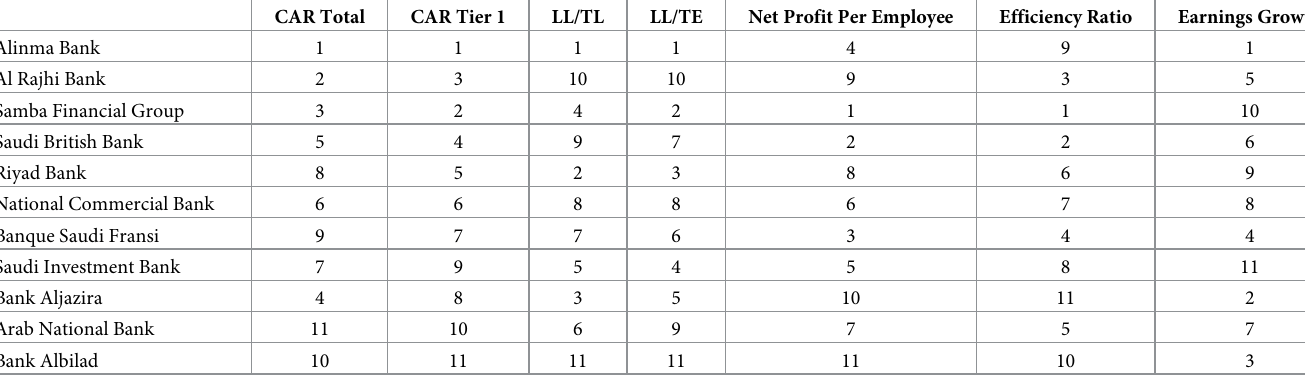
Table 1. Ranks of Saudi banks using CAMEL composites (C, A,